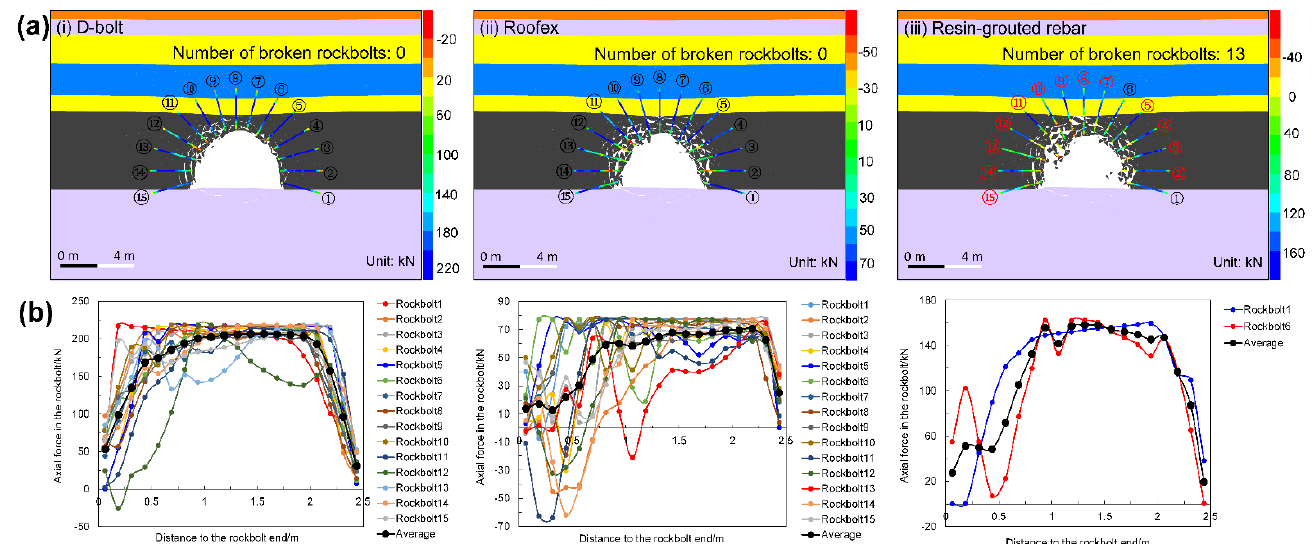
Figure 18. Simulated contours ( a ) and distribution of the axial force ( b ) in rockbolts for the tunnel supported by different rockbolts. The black and red numbers indicate intact and broken rockbolts, respectively. The positive value of axial forces represents a tensile load.